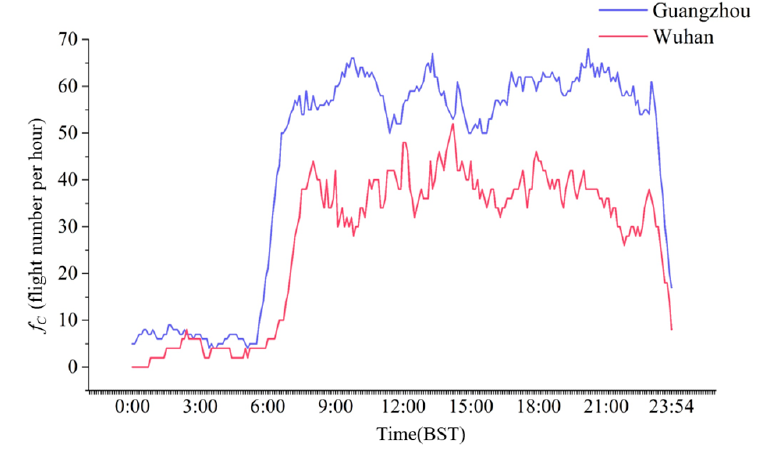
Figure 7. The curve of historical flight numbers under clear weather. Each flight has a set of data, including the planned data, the radar trajectory data and the corresponding weather data. This set of data for each flight is a sample. In order to improve the reliability of the predicted capacity and visualize the result through case analysis for a consecutive period of time, ten-fold cross-validation is used for terminal area capacity prediction. The samples are divided into ten groups. Group 1 to group 9 include samples of 3 days, and group 10 includes samples of 2 days. Table 1 states the sample set partition and the number of samples in each group. One of the ten groups would be picked to test, and the rest nine groups would be used to train. All of the groups would be once selected to test. Therefore, there would be ten experiments in total. The final MSE , MAE , and MAPE of each algorithm are averaged over ten experiments to evaluate the